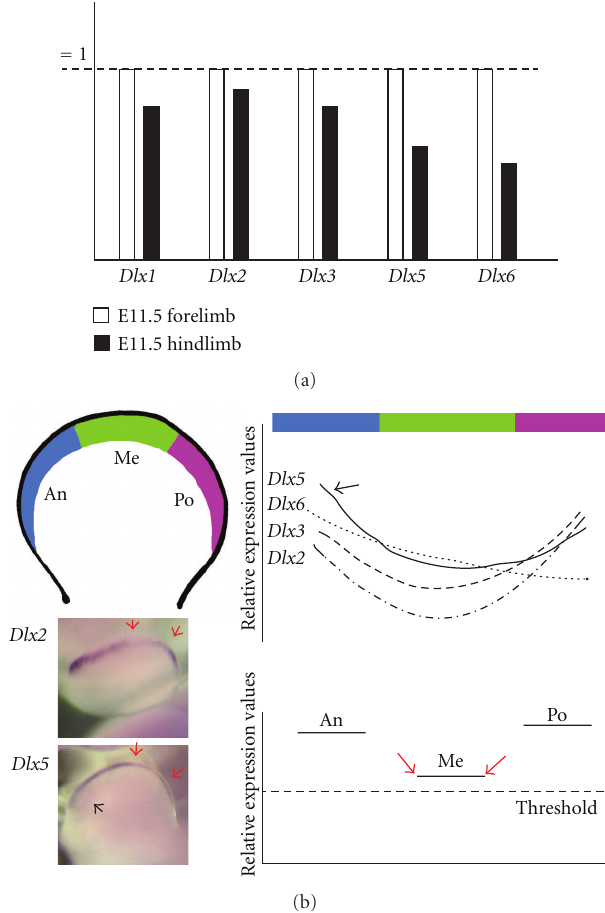
Figure 3: Quantitative and dynamic expression of Dlx genes during limb development. (a) Expression of Dlx genes in the hindlimbs (HL) and forelimbs (FL) limbs, at the same embryonic age, by qPCR. In the HL, the expression is always lower, as compared to the FL. This di ff erence, most likely reflecting the developmental lag of the HL compared to the FL, may explain the finding that malformations a ff ecting the HL are more severe. (b) Relative expression of Dlx genes along the length of the AER, from anterior (An) to medial (Me) to posterior (Po) regions (indicated with a color code). The expression of single Dlx genes is not uniform, and considering their partial redundancy the “global” expression is lower in the central wedge. This region of the AER appears to be more “sensitive” to genetic alterations and is specifically a ff ected in